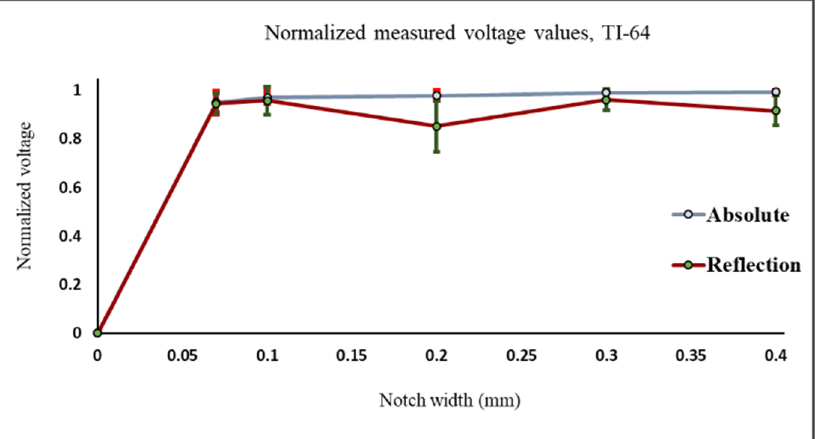
Figure 12. Normalized values of the measured voltage for both probes on top of plates made of titanium with notches with different